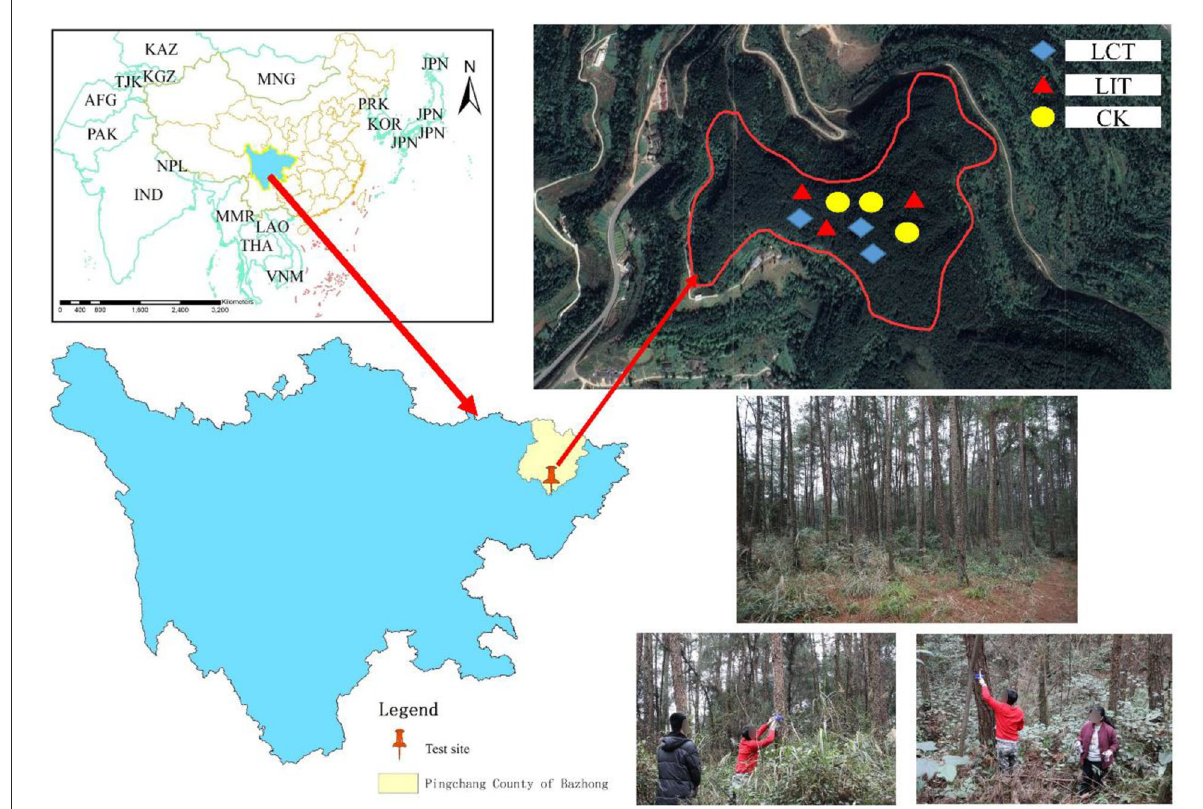
FIGURE1 The map of the study sites (Location map of Liumen Town, Pingchang County, Bazhong City, Sichuan Province, China). The logging methods are LCT , logging of competitive trees; LIT , logging of inferior trees; CK , unlogged